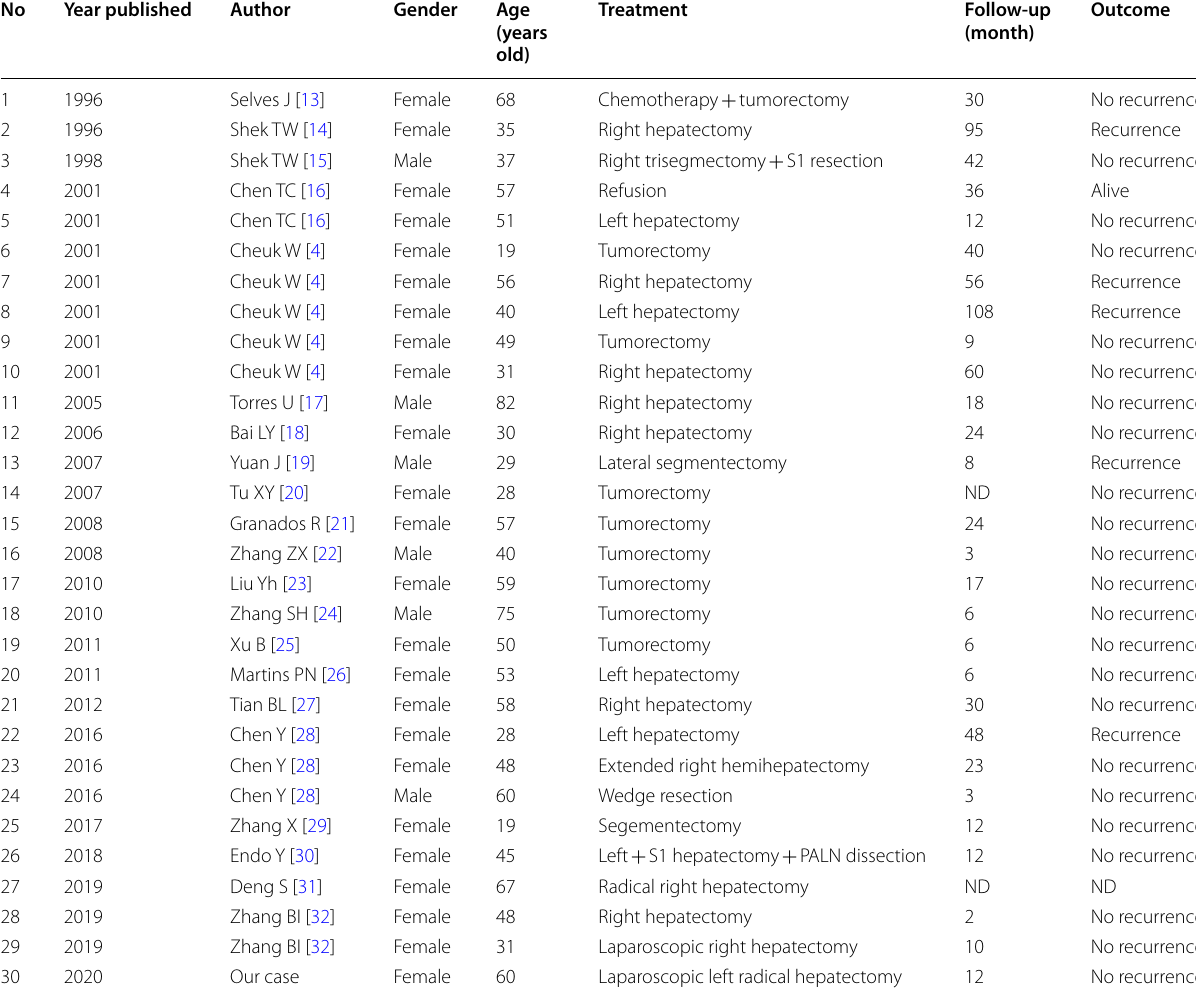
EBV: Epstein–Barr virus; FDCS: follicular dendritic cell sarcoma; PALN: paraaortic lymph node; ND: not